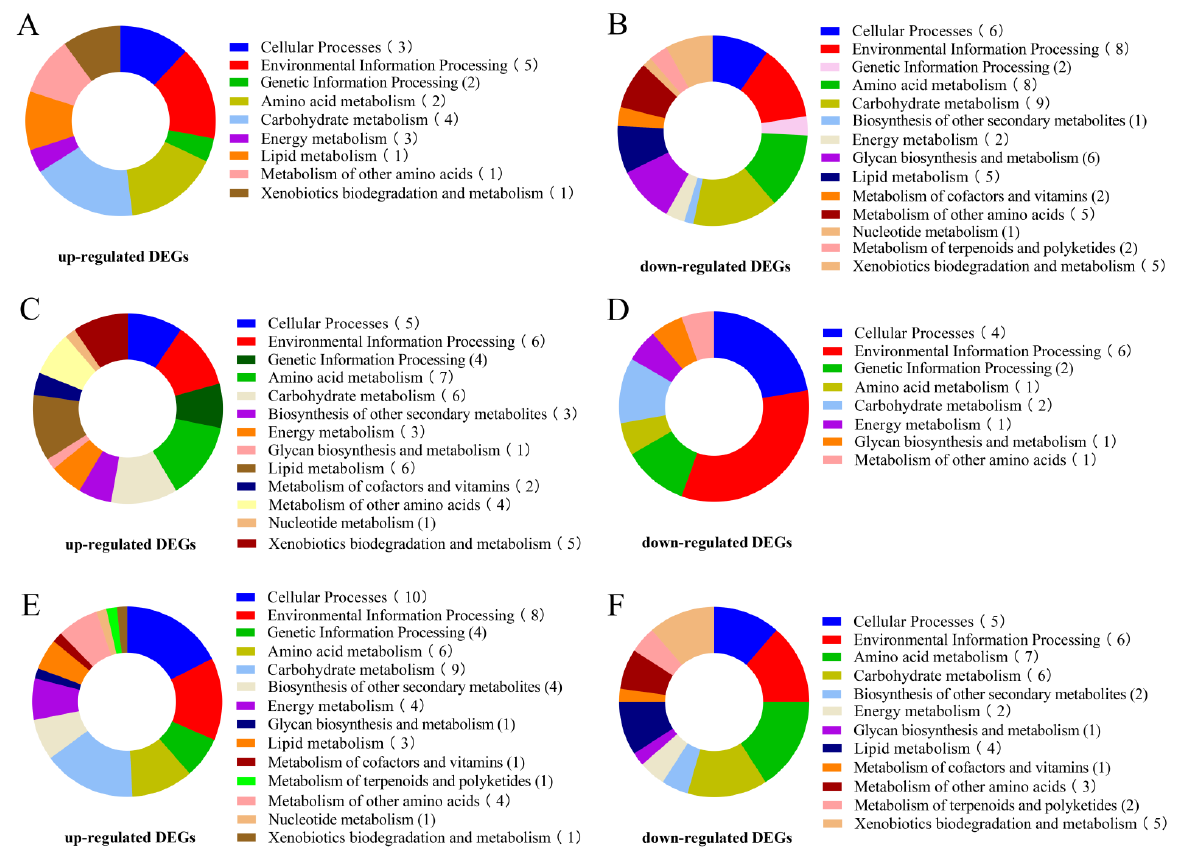
Figure 7. Enrichment of DEGs in KEGG pathways. ( A ) Functional KEGG categories enriched by up-regulated DEGs in B2 vs. B1. ( B ) Functional KEGG categories enriched by down-regulated DEGs in B2 vs. B1. ( C ) Functional KEGG categories enriched by up-regulated DEGs in B3 vs. B1. ( D ) Functional KEGG categories enriched by down-regulated DEGs in B3 vs. B1. ( E ) Functional KEGG categories enriched by up-regulated DEGs in B4 vs. B1. ( F ) Functional KEGG categories enriched by up-regulated DEGs in B4 vs.